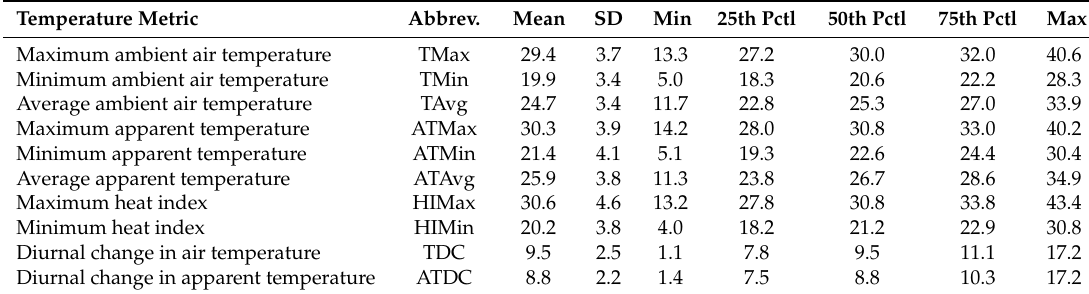
Table 1. Descriptive statistics for various temperature metrics in Atlanta during the warm seasons (May–September), 1993–2012 ( n = 3060 days, in units of ◦ C). (Abbreviations: SD, standard deviation; Min, minimum; Pctl, percentile; Max, maximum).